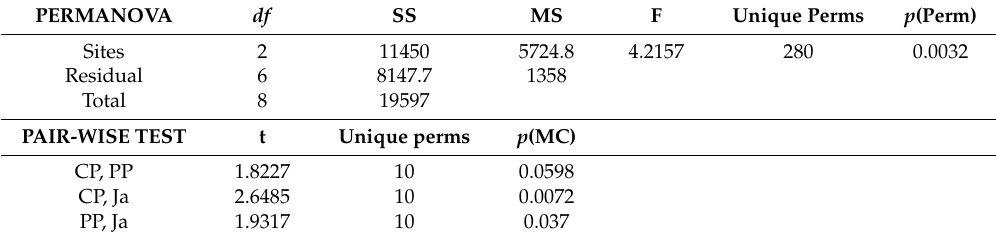
Table 4. Results from PERMANOVA on Bray-Curtis similarity of mollusc assemblages among the three sites (CP Cabo de Palos, PP Punta Prima and Ja Jávea) after log (x + 1) transformation and pair-wise comparison using 4999 permutations ( df : degrees of freedom, SS: sum of squares, MS: mean square, F: F-value, Unique perms: the number of unique permutations, p (perm): calculated probability value).